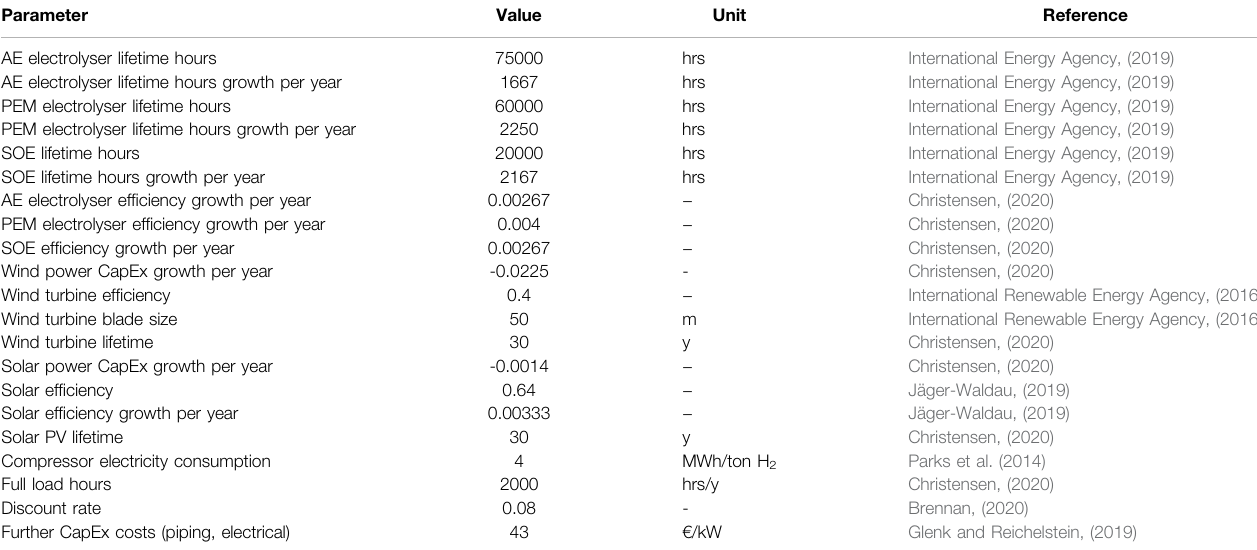
TABLE 2 | Static economic parameters assumed for the production cost of H 2 in 2020. “ Growth per year ” refers to the assumed increase of the parameter, per year from 2020, if the electrolyser was to be built in a future year.